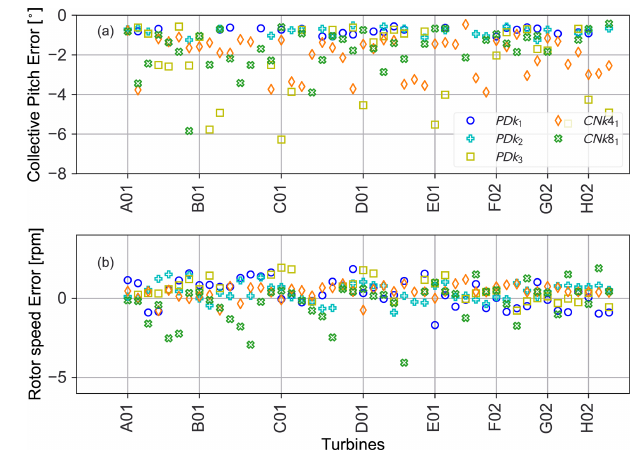
Figure 14. Errors between LES time-averaged collective pitch (a) and rotational speed (b) of individual turbines and field SCADA measurements. Missing data points correspond to missing data.